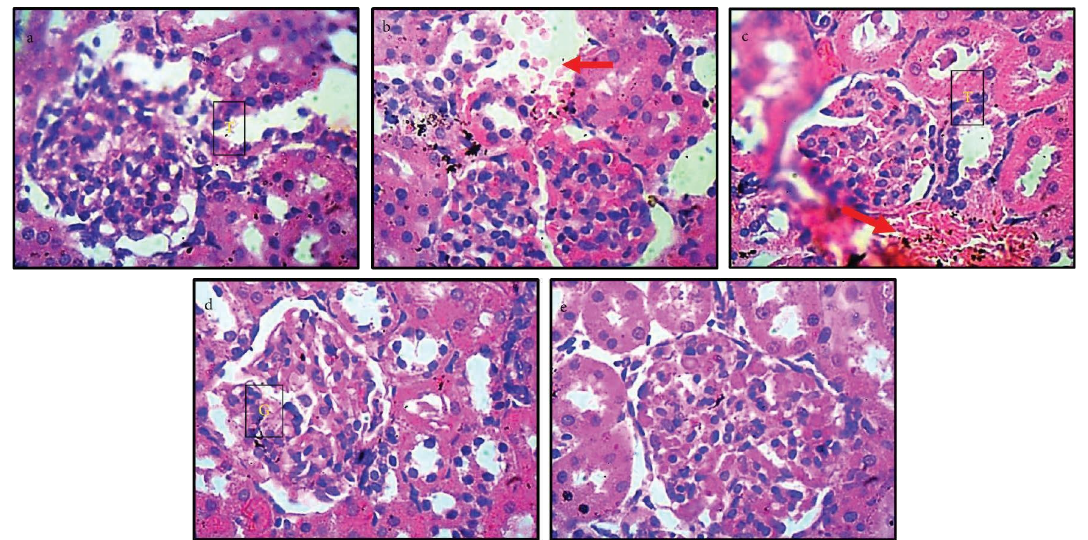
Figure 6: Magnifed views of kidney micromorphological section demonstrated by hematoxylin and eosin staining at high magnifcation ( × 400). Te renal cortex, renal tubules, glomeruli, and mesangial cells as well as proximal and distal renal convoluted tubules are all visible across the various groups. (a) Normal control (normal rats). (b) NaAr-induced toxicity (sodium arsenate-intoxicated rat). (c) NaAr-Quer (sodium arsenate-intoxicated rat +30mg/kg quercetin treatment). (d) NaAr-Quer+ Zn (sodium arsenate-intoxicatedrat +quercetin-Zn complex treatment). (e) NaAr-Quer+Fe (sodium arsenate-intoxicatedrat +quercetin-Fe complex treatment). Red arrow � degenerative changes characterized with congested proximal and convoluted renal tubules, infltrated renal parenchyma by red infammatory cells. T � renal tubules, G �